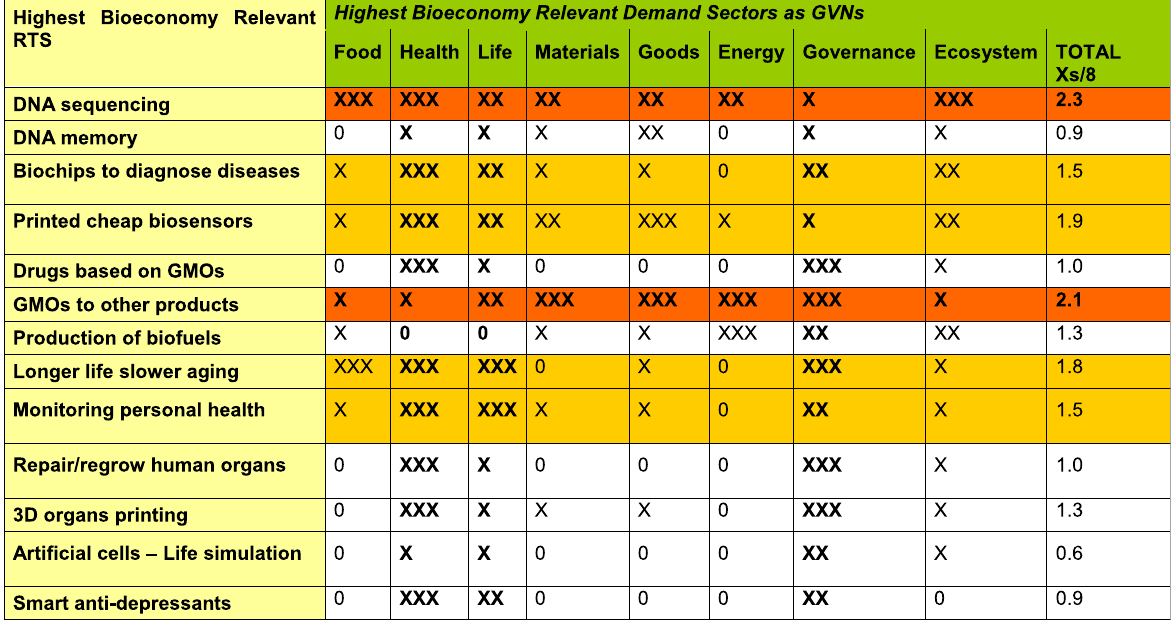
Table 4 Assessing the compatibility between key bioeconomic “ questions ” (identified Global Value-Producing Networks or GVPNs)